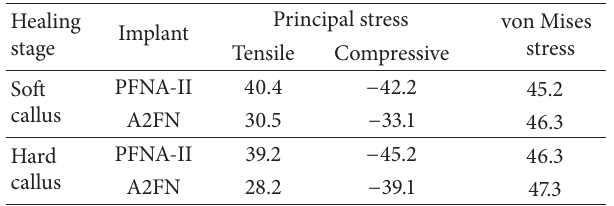
Table 2: The peak von Mises stress of the implant configurations in two healing stages (MPa).